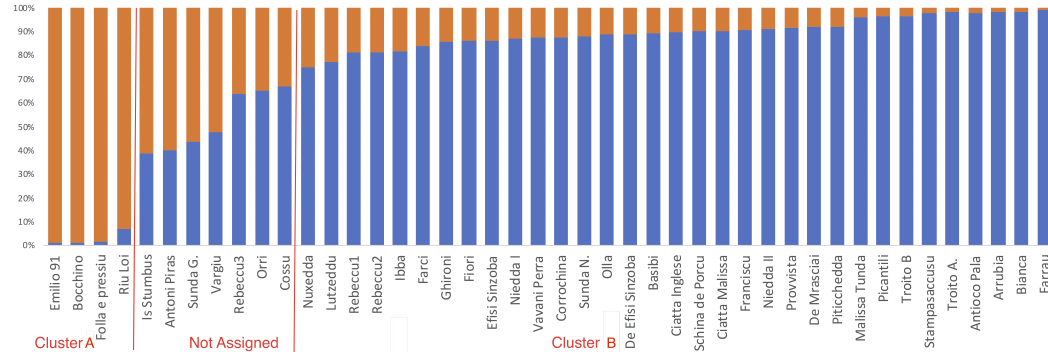
Figure 4. Most probable partition of cluster 1, as revealed by STRUCTURE analysis. Bars represent individuals, and coefficients of membership (Q) to specific clusters are reported with different colors. Cluster assignment was based on a membership threshold set at